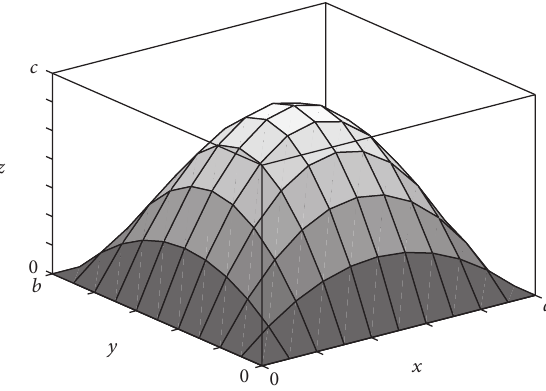
Figure 2: The membrane system initial and boundary